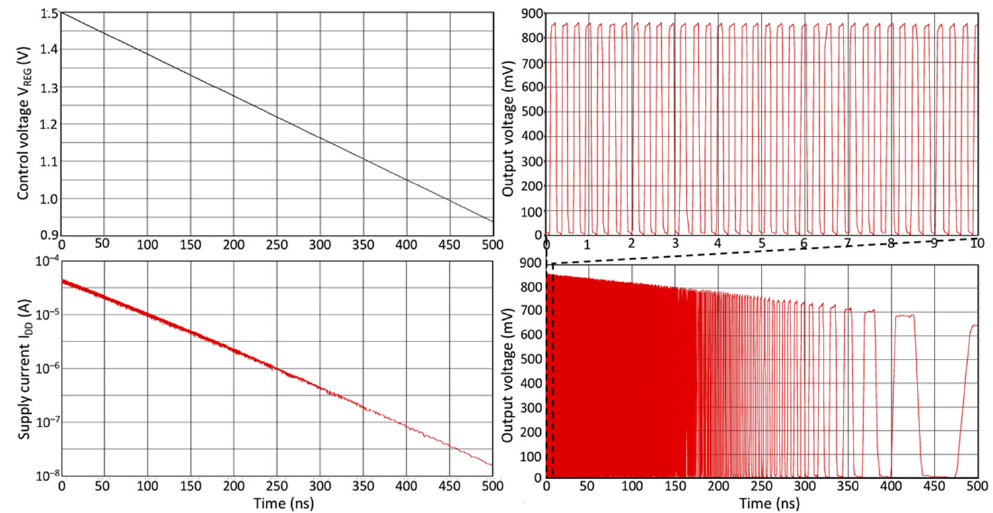
Figure 21. Simulated operation of five-stage CBip ring oscillator with supply voltage controlled by a NMOS transistor: control voltage, supply current (log scale) and output voltage as a function of time; V CC = 1.2 V, temperature 300 K.